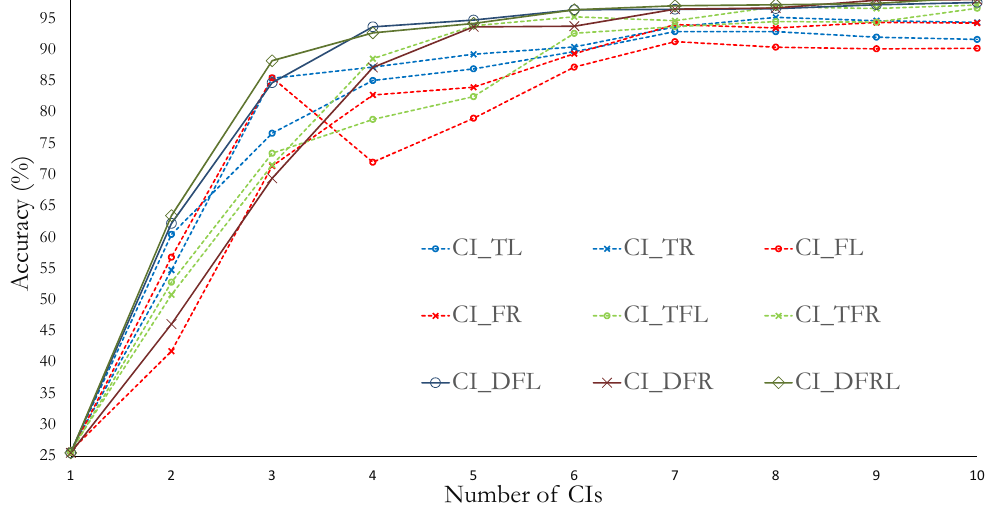
Figure 5. Accuracy vs. different numbers of selected CIs.